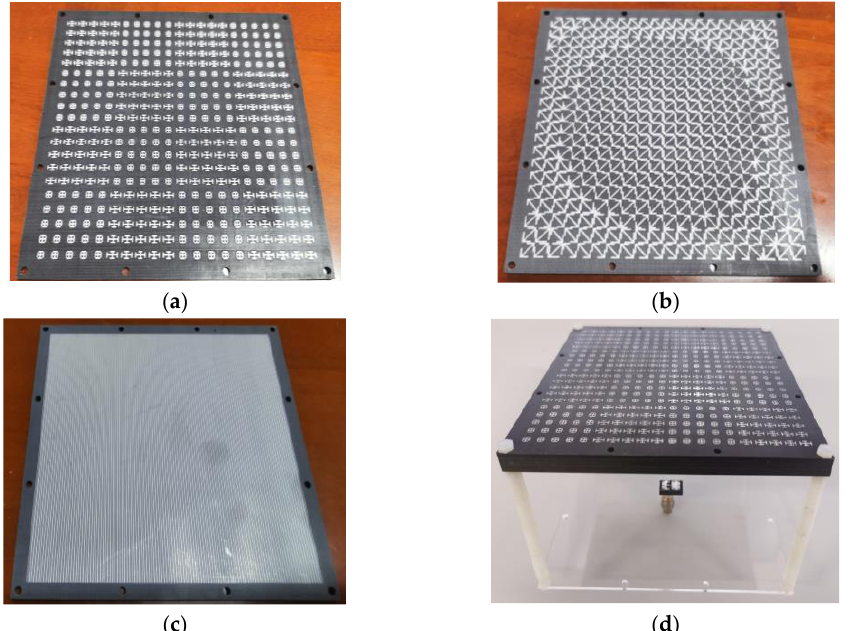
Figure 18. Finished product: ( a ) checkerboard structure; ( b ) metal arrow; ( c ) metal grid; ( d ) transmission array antenna.